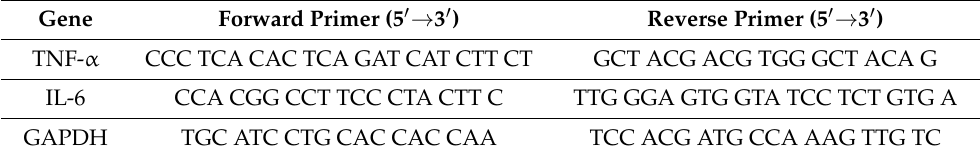
Table 1. Primer sequences and real-time PCR